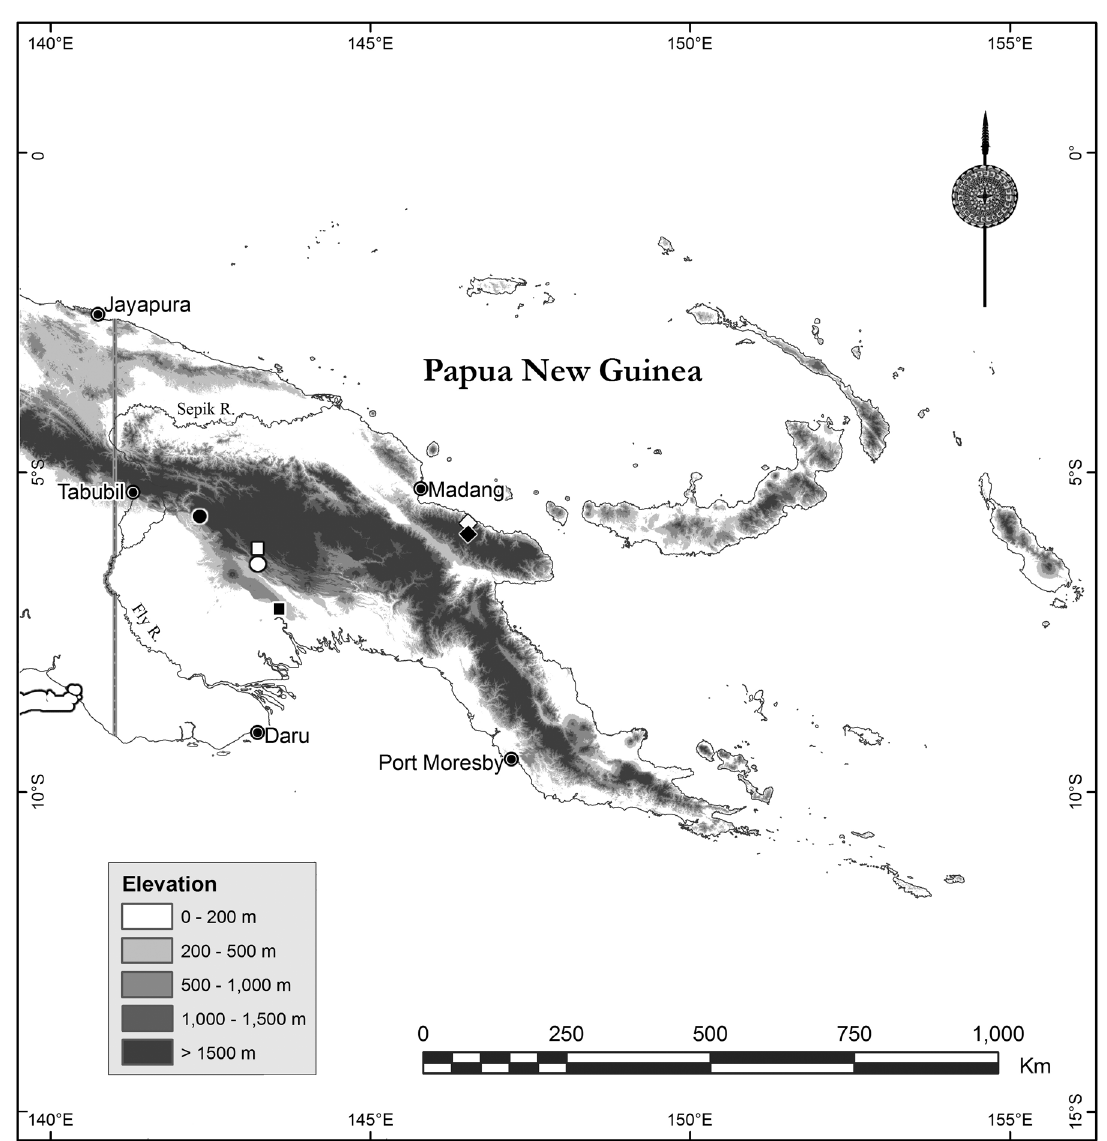
Figure 14. Map showing collection localities of three new Choerophryne species. Symbols in white are type localities, those in black represent additional collection localities. Squares = C. crucifer ; circles = C. multisyllaba ; diamonds = C. bisyllaba . Elevation data are based on 30 m LiDAR Digital Elevation Model (DEM) data from ASTER GDEM v2 (product of METI and